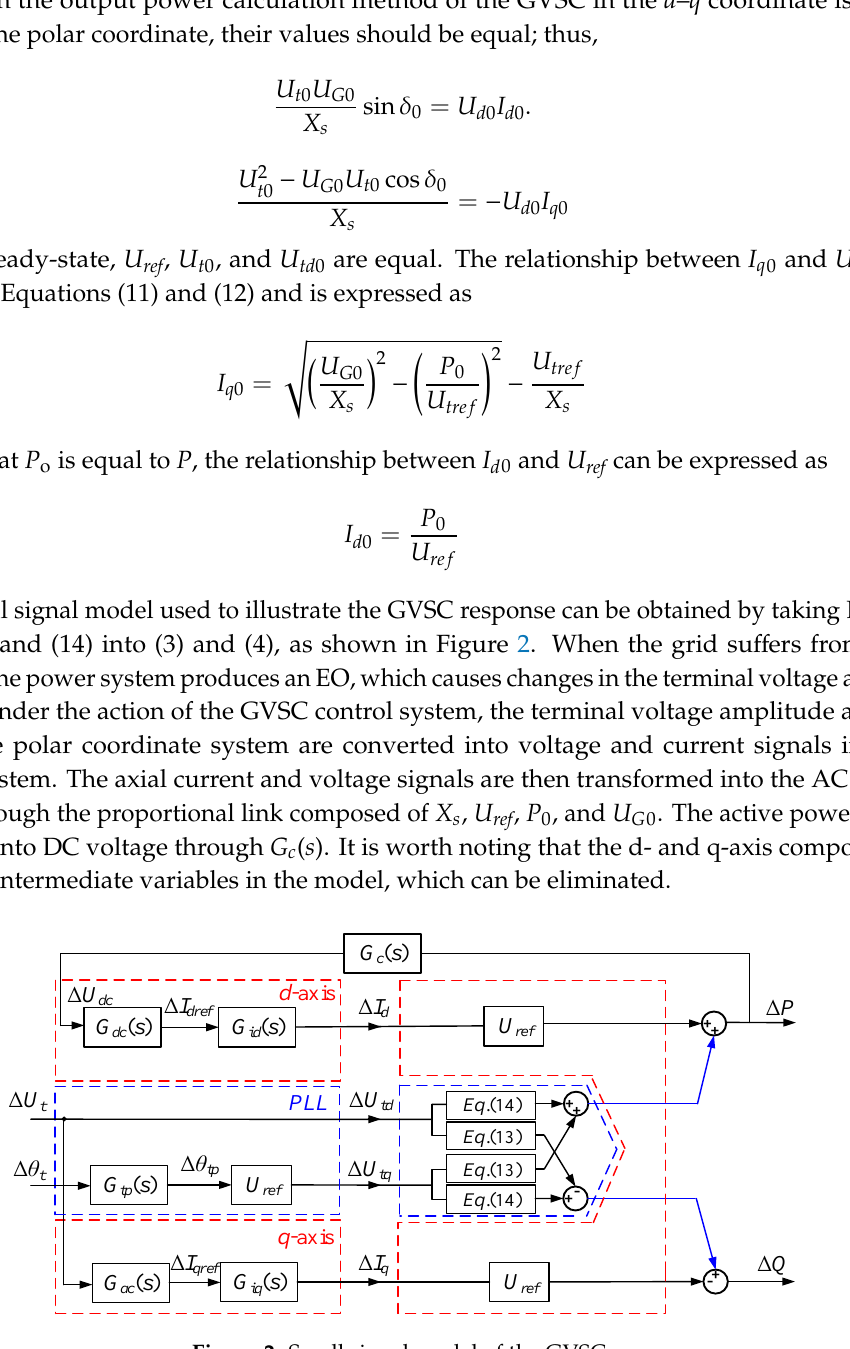
Figure 2. Small signal model of the GVSC.